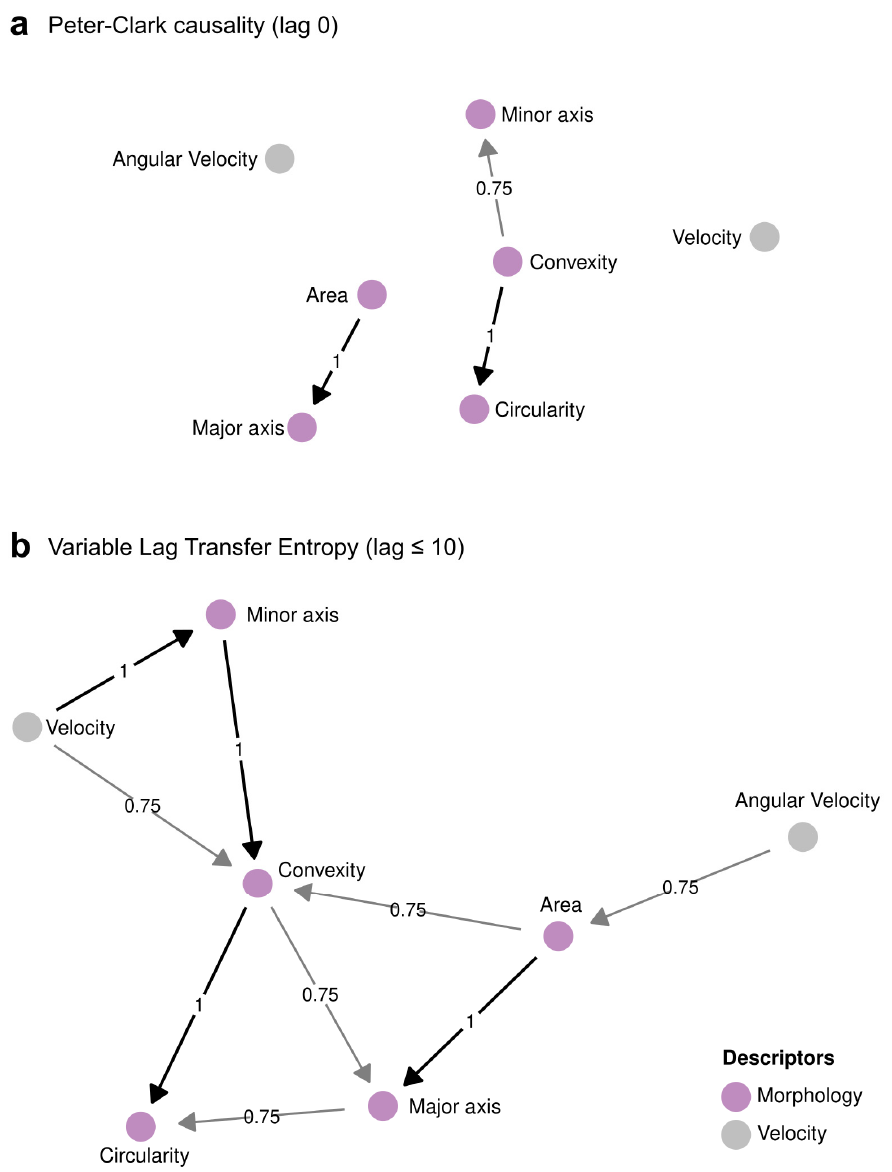
Figure 2. Causality analysis between morphology and movement variables. Directed Graphs (DG) for the ( a ) PC and ( b ) VLTE algorithms are depicted with a conservation of 75%; for the VLTE algorithm, the maximum selected lag was 10; in both cases, a p -value < 0.05 was considered significant. Nodes are all variables studied in the causality analysis. In grey, velocity descriptors; in pink, morphology descriptors. Edges indicate if nodes are connected by a significant causality relation, and causal direction (arrowhead). Edge weights represent the conservation of the relation across all individual cases, i.e., how many times a significant relation appears on the dataset. Weights are shown on edges and represented by line width and grayscale intensity.